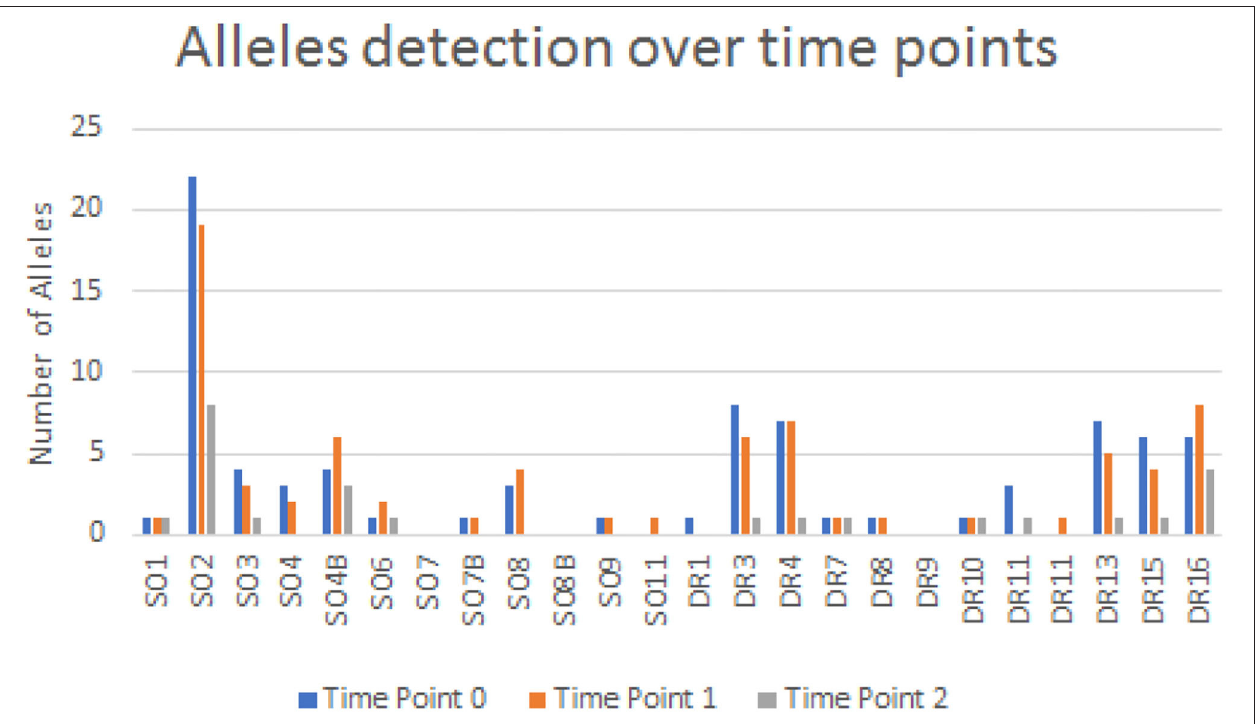
FIGURE 2 | Frequency and severity of microchimerism (number of chimeric alleles detected) according to the subject group tested. Only patients with TDT exhibited ≥ 3 positive chimeric alleles, and there was a big difference in the proportion of subjects exhibiting 1 or 2 chimeric alleles, between TDT patients and controls. TDT, transfusion-dependent β -thalassemia.